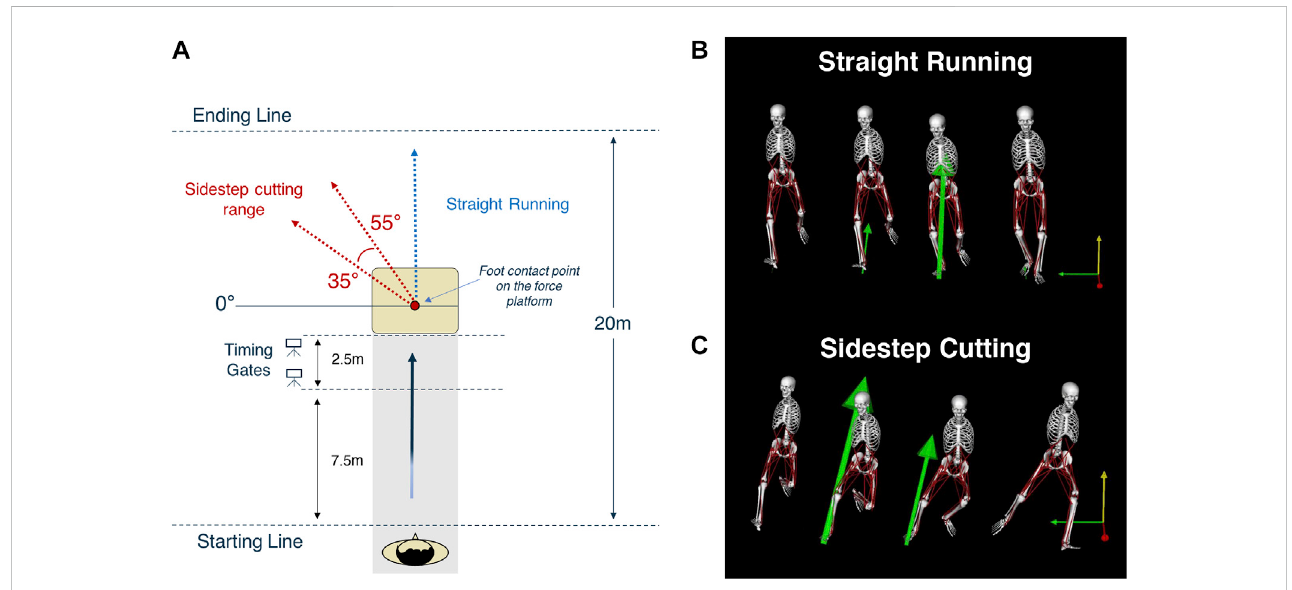
FIGURE 1 Experimental Procedure. (A) The sidestep cutting technique was carried out between 35 ° and 55 ° to the left of the path of travel. Sprinting velocity was controlled by monitoring the participant ’ s velocity in the 2.5 m range prior to contact with the ground reaction force measurement apparatus. (B,C) The two running condition types performed in the study. The image were extracted at using open source model provided in OpenSim (Stanford University, Stanford, CA, United